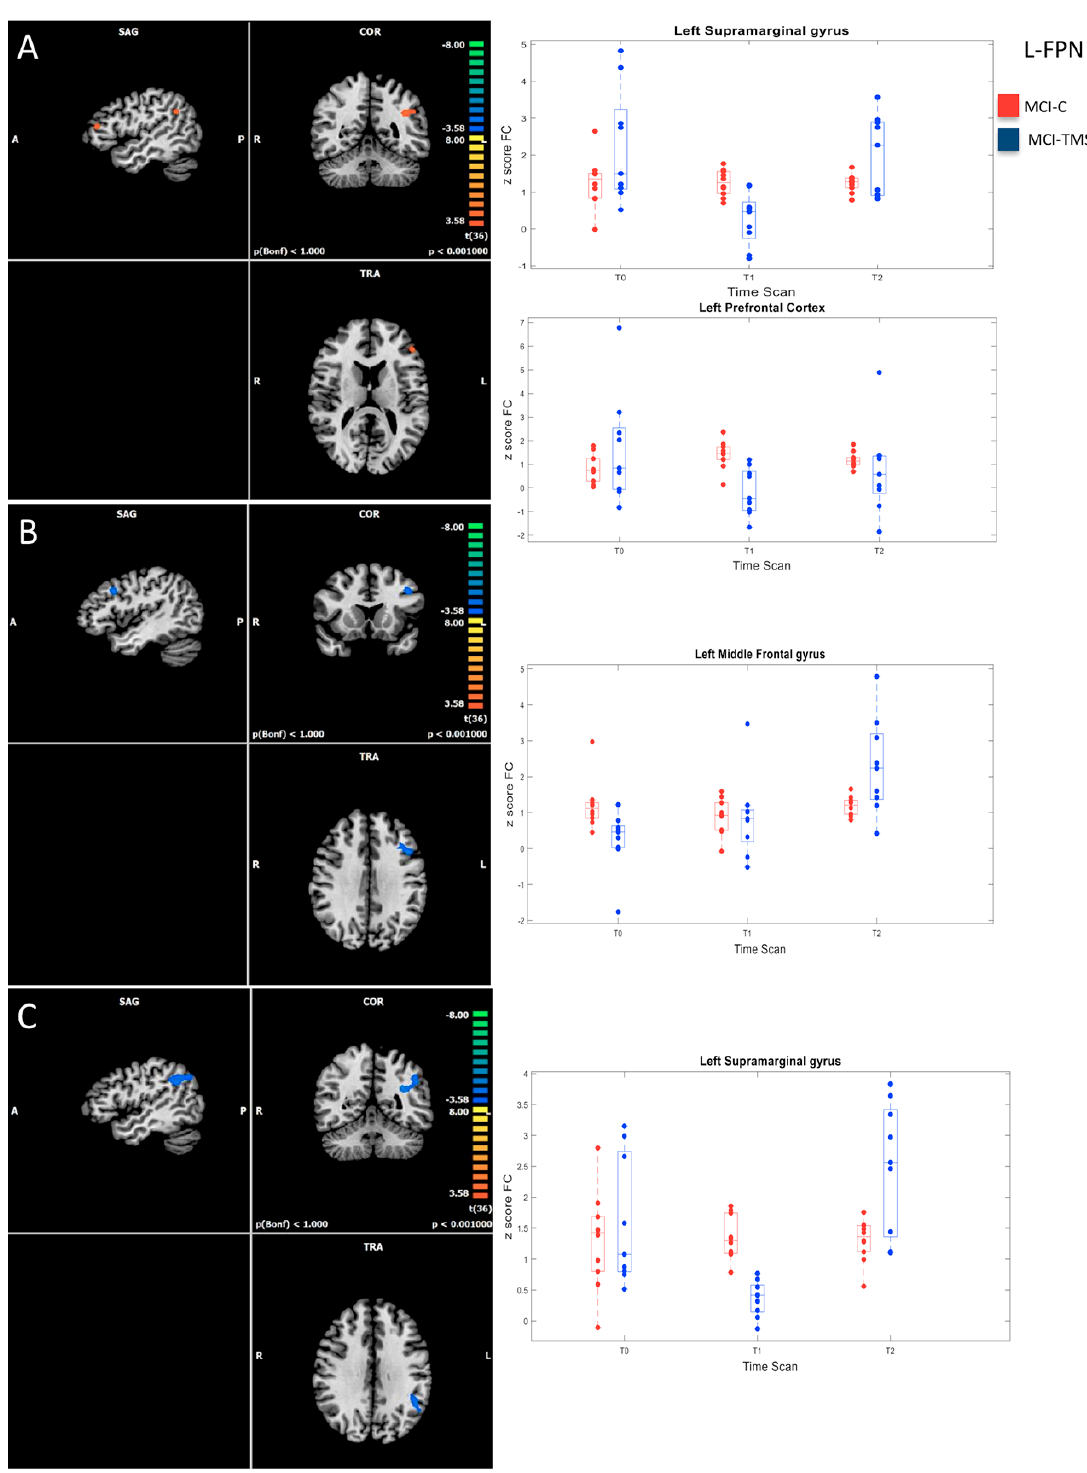
Figure 4. On the left: whole-brain significant connectivity differences between MCI − TMS patients at different time points ( p ≤ 0.001 cluster-level-corrected) within left frontoparietal network. ( A ) T0 MCI − TMS vs. T1 MCI − TMS. ( B ) T0 MCI − TMS vs. T2 MCI − TMS. ( C ) T1 MCI − TMS vs. T2 MCI − TMS. On the right: corresponding box − plot of the average ICA z − scores. We also reported values extracted from the MCI − C group at different time points to show a relatively constant FC in these subjects who have not undergone stimulation. No significant difference was present for other comparisons.